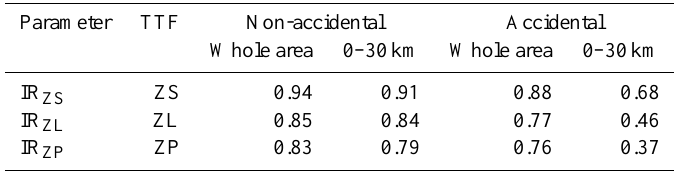
Figure 7. Results of concentration ratio estimated for small phytoplankton (PS), small zooplankton (ZS) and predatory zooplankton (ZP) in the whole study area (left) and for those populations located at less than 30km from FNPP (right). The blue vertical line separates the pre- and post-accident periods. Table 3. Correlation coefficients ( r ) between the ingestion rates and the TTF of different zooplankton